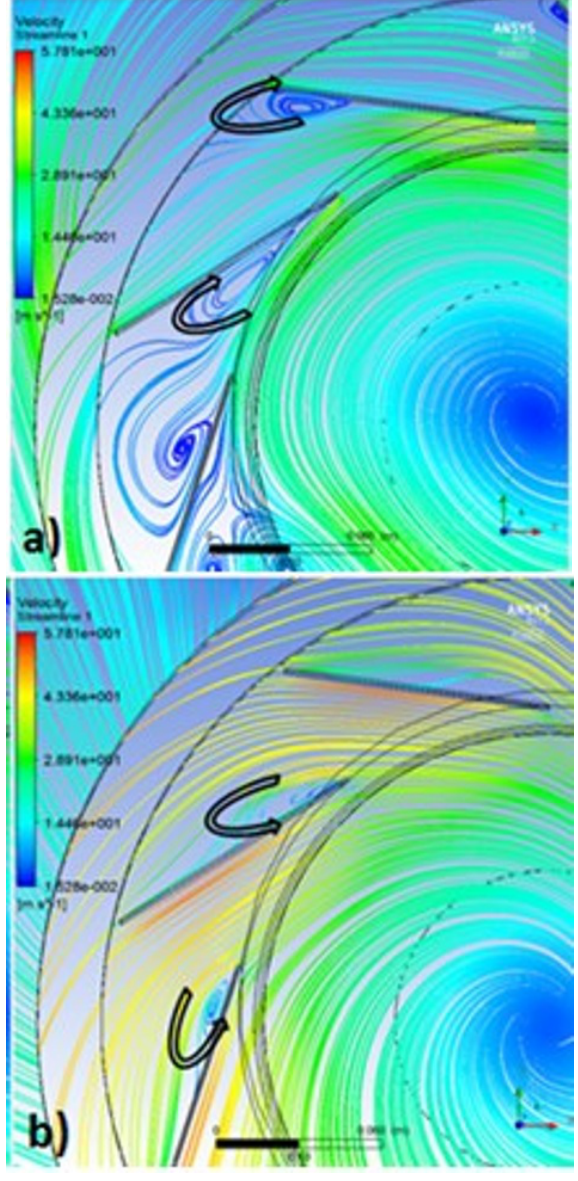
Fig. 1. Flow deflection at the operation point a) below-optimal and b) above-optimal